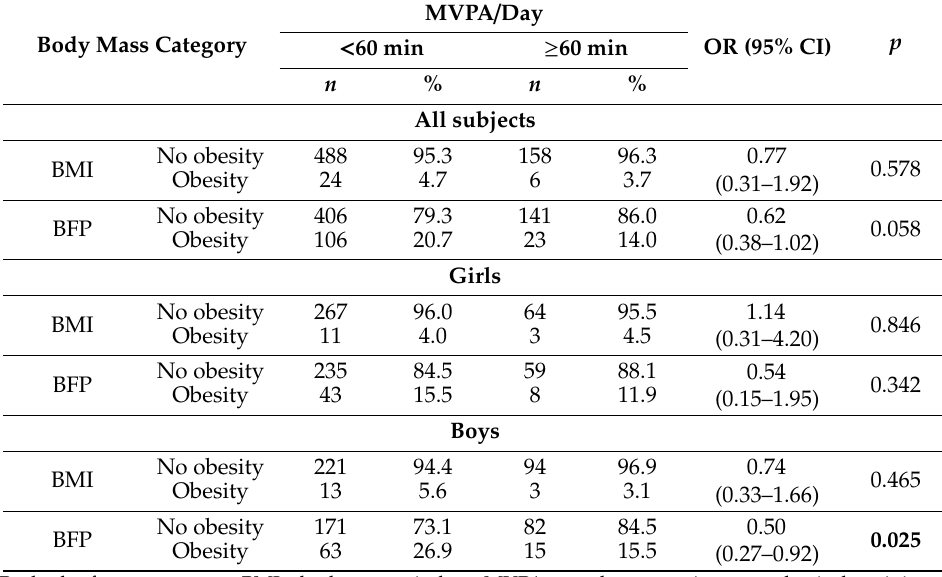
Table 4. Multinomial regression analysis showing the association between the MVPA recommendation and obesity status.